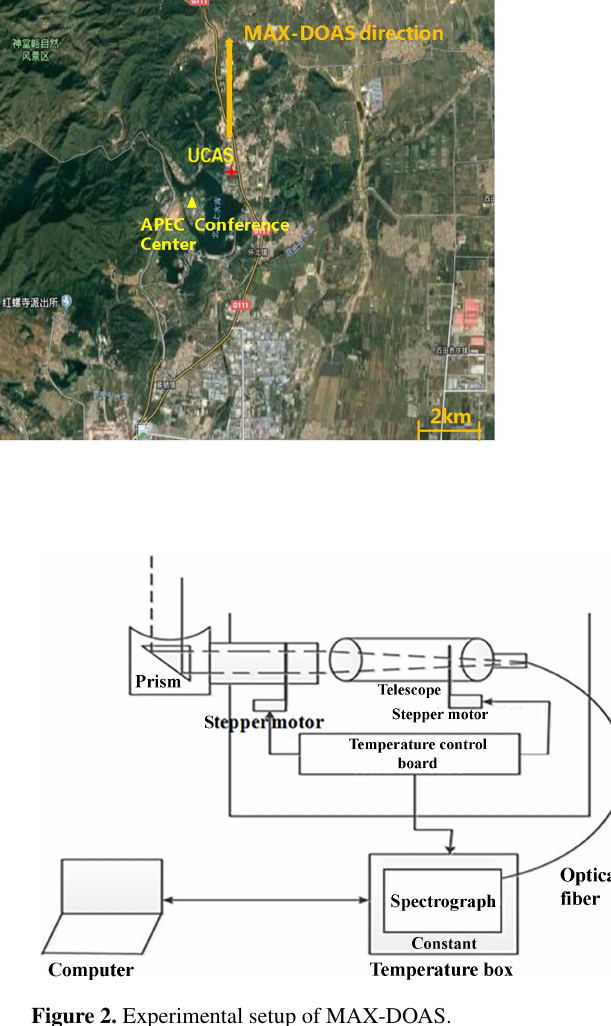
Figure 2. Experimental setup of